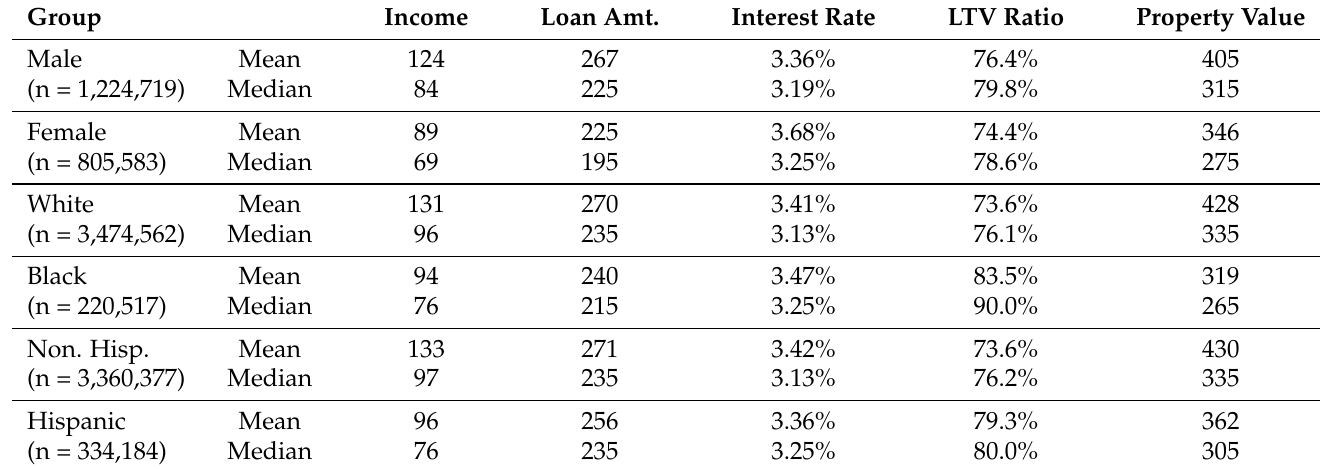
Table 1. Population statistics for HMDA (note: all values are expressed in USD 1000; the interest rate and LTV, the loan-to-value ratio, between the loan amount and property value are expressed as a percentage; lastly, groups are split via sensitive parameters of sex, race, and ethnicity,